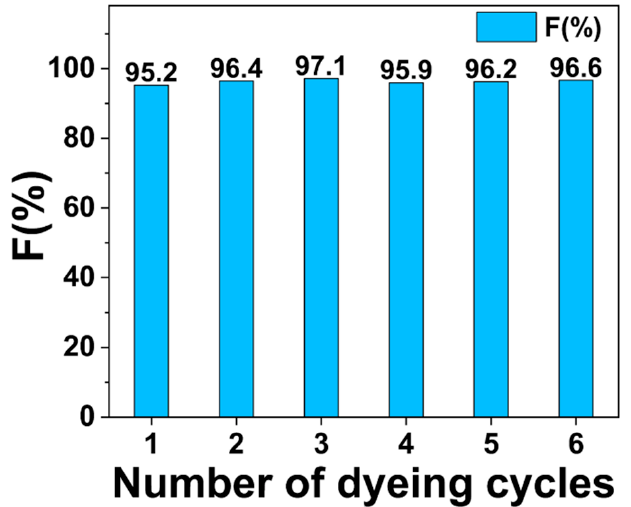
Figure 10. Recycling performance of ethanol-water-NaOH system, where V EtOH :V H dosage = 70 g/L.